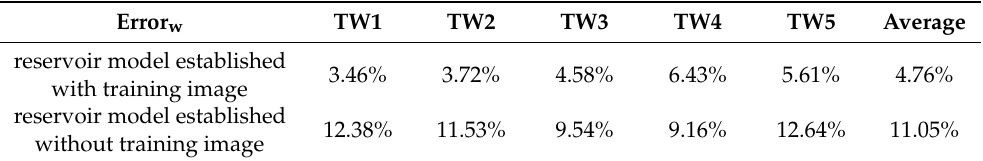
Table 4. Errors of water cut simulated from reservoir models established by the methods with training images or not. Error w TW1 TW2 TW3